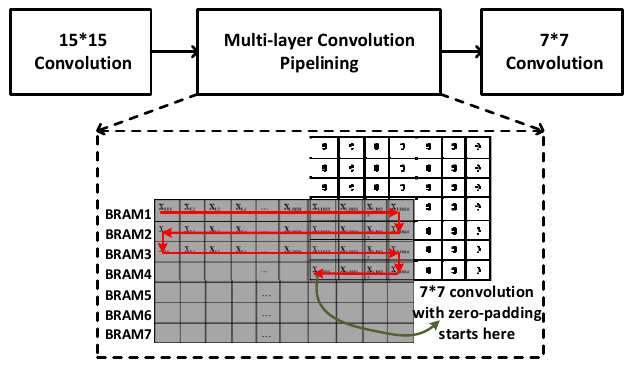
Figure 5. Multi-layer convolution pipelining.